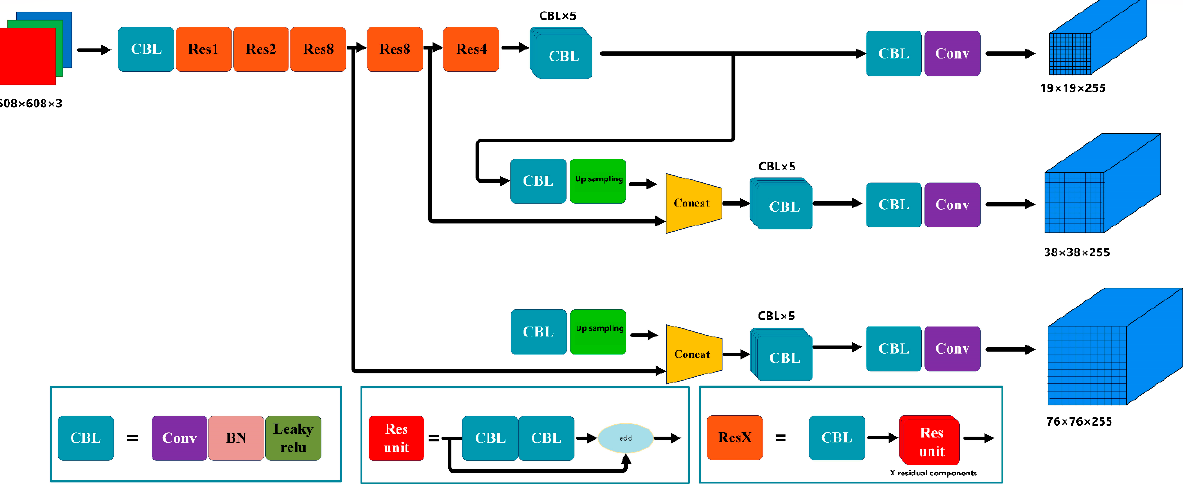
Figure 4. YOLOv3 structure. CBL is the smallest component of the YOLOv3 network architecture, which consists of Conv (convolution) + BN + Leaky relu; Res unit is the residual component; ResX, X stands for number, there are Res1, Res2, … , Res8, etc., which consists of a CBL and N residual components.